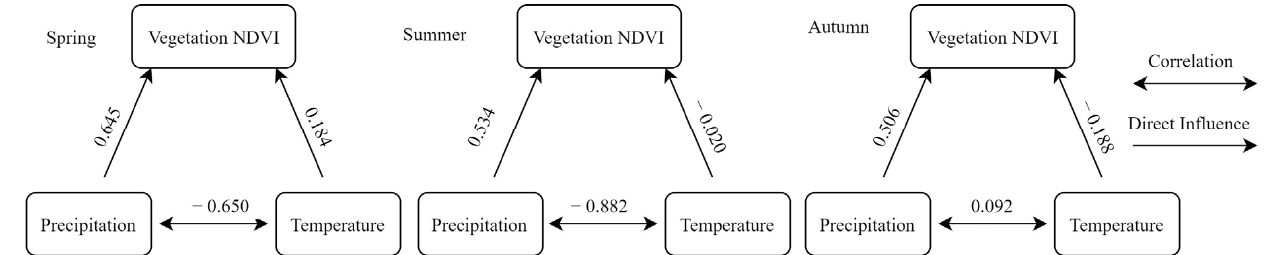
Figure 6. Path analysis of the effects of precipitation and temperature on vegetation NDVI. In summer, the direct effect of precipitation on vegetation NDVI is 0.534 (shown in Figure 6), which indicates that the increase in precipitation promoted vegetation